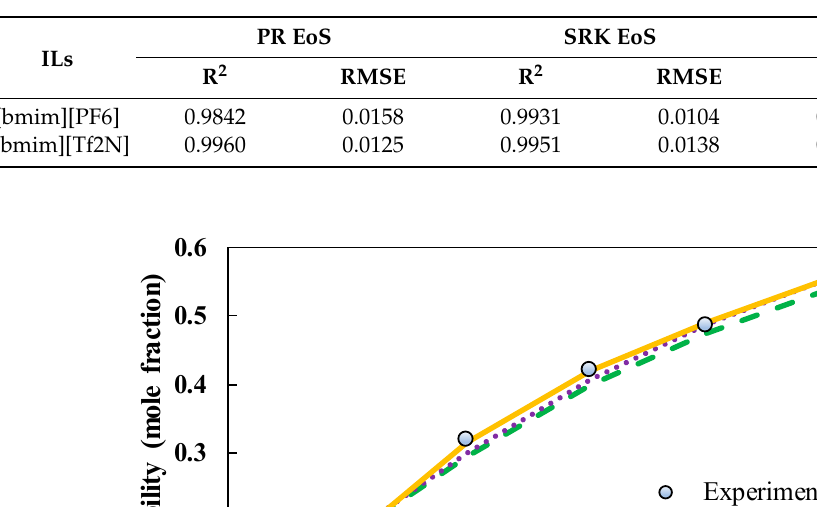
Table 6. Comparison of R 2 and RMSE of EoS and the best proposed model.